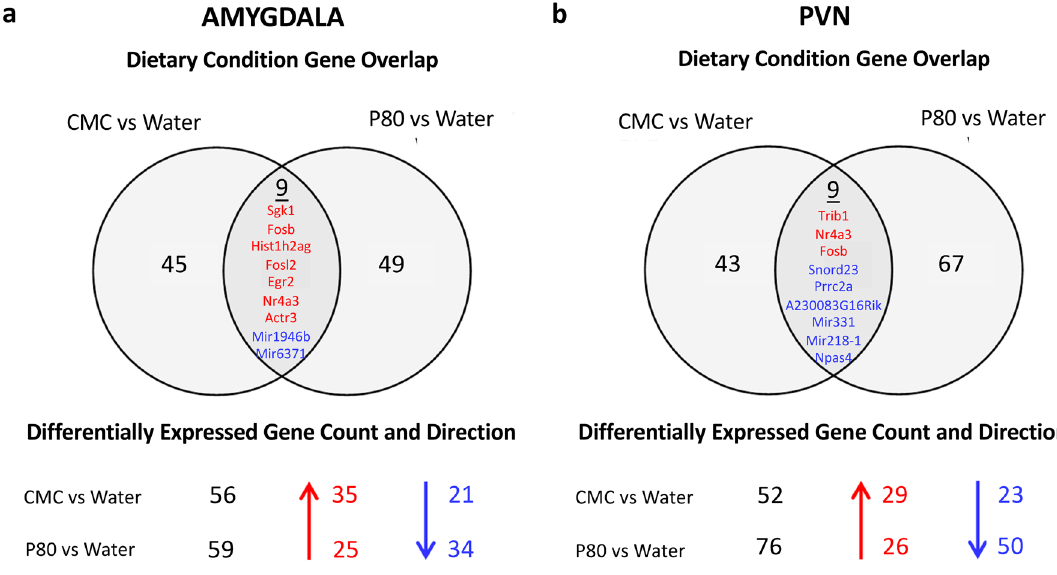
Figure 3. Quantified DEGs in the amygdala and PVN after treatment with P80 or CMC. Quantified genes were differentially expressed and met analysis criteria with an adjusted p-value of less than 0.05 and exceeded log2fold change of 1 and − 1. Venn-diagram shows the overlap of significant differentially expressed genes between CMC and P80 treatments. Upregulated DEGs are in red and downregulated DEGs are in